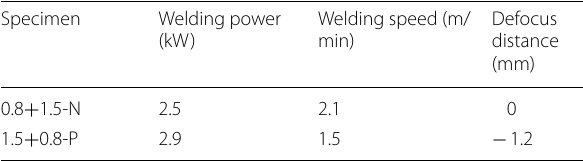
Table 2 Laser welding parameters of the penetration and